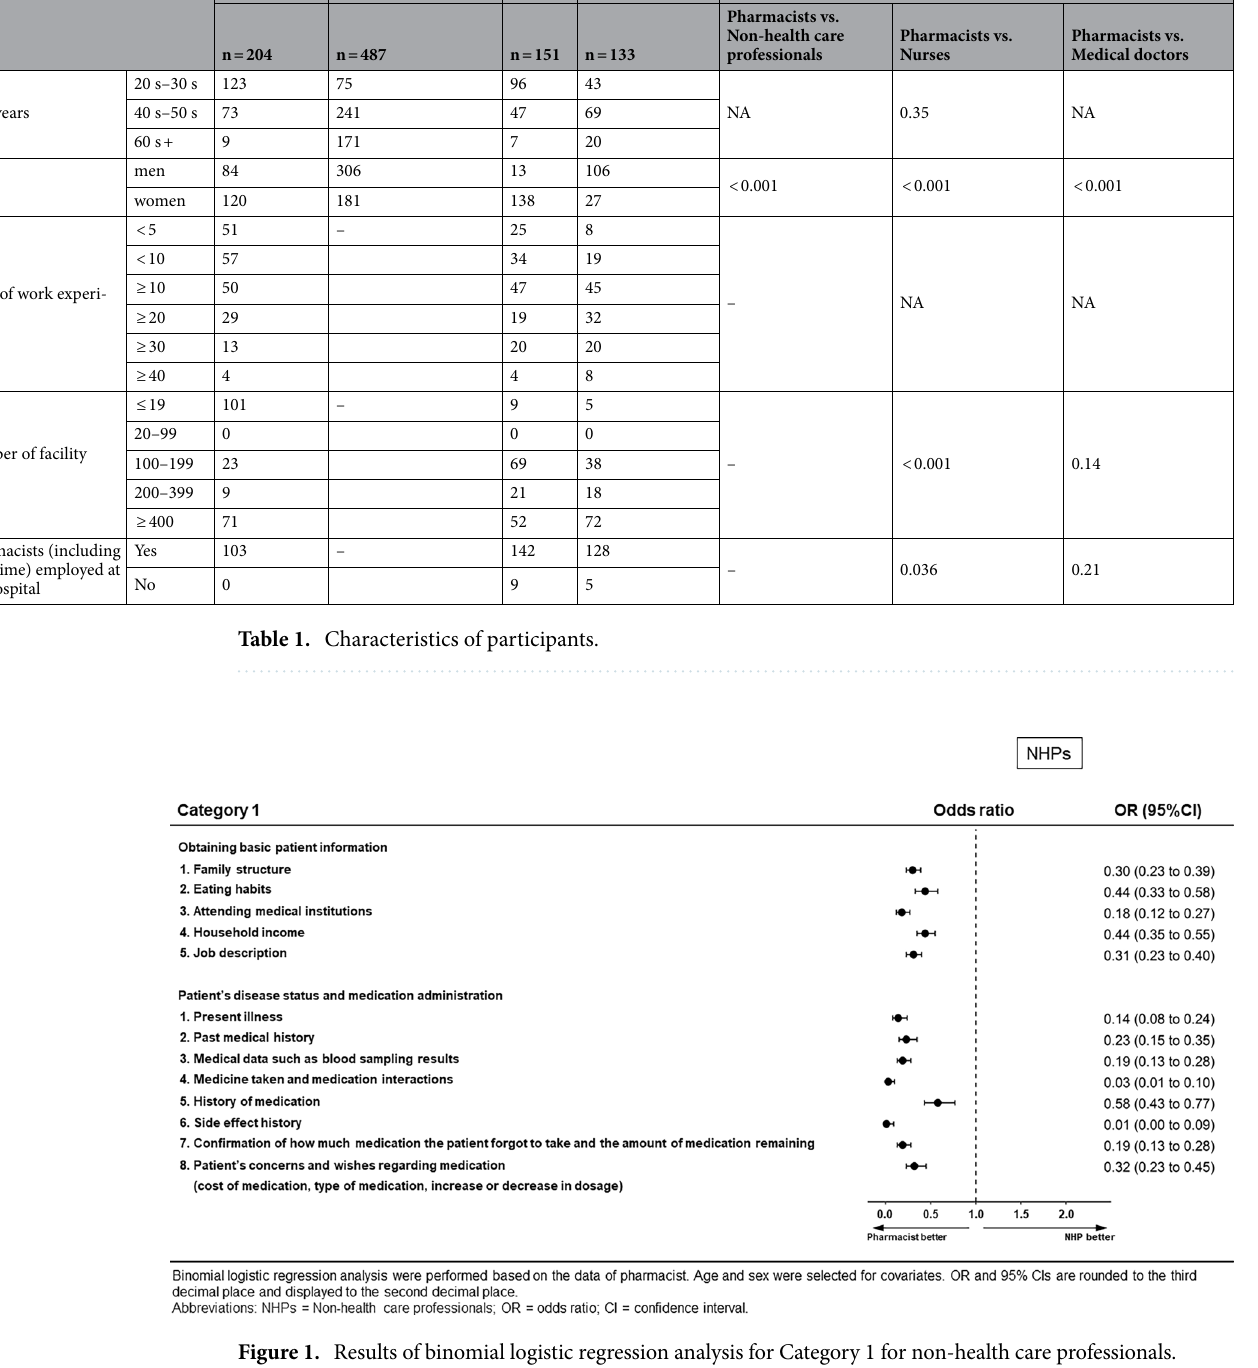
Figure 1. Results of binomial logistic regression analysis for Category 1 for non-health care